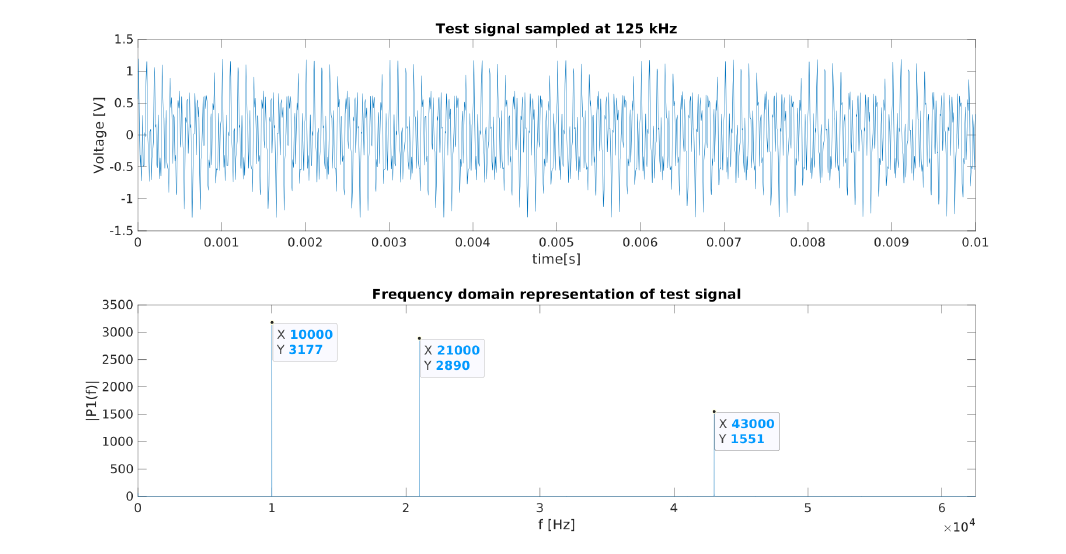
Figure 7. To prove the timewise accuracy of the generated firmware, a test signal of 4 seconds consisting of three sine waves with a frequency of 10, 21, and 43 kHz is used. The figure displays the results of the captured test signal using the test setup from Figure 6. Five-hundred-thousand samples of the test signal are used for the Fourier transform, leading to a frequency resolution of 0.25 Hz per bin. The fact that the peaks in the frequency analysis are situated at exactly 10, 21, and 43 kHz verifies that the automatically generated platform-specific timing is exact. The amplitude attenuation for the higher frequencies is due to the presence of an analog Sallen–Key low-pass filter with a cut-off frequency of approximately 26 kHz